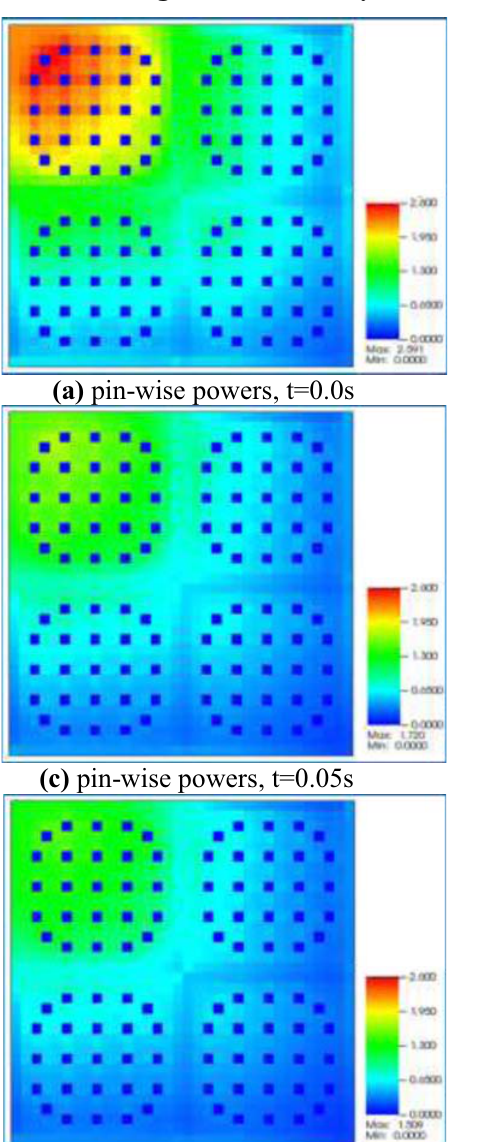
Figure 3. Uncertainty of the normalized fuel-assembly